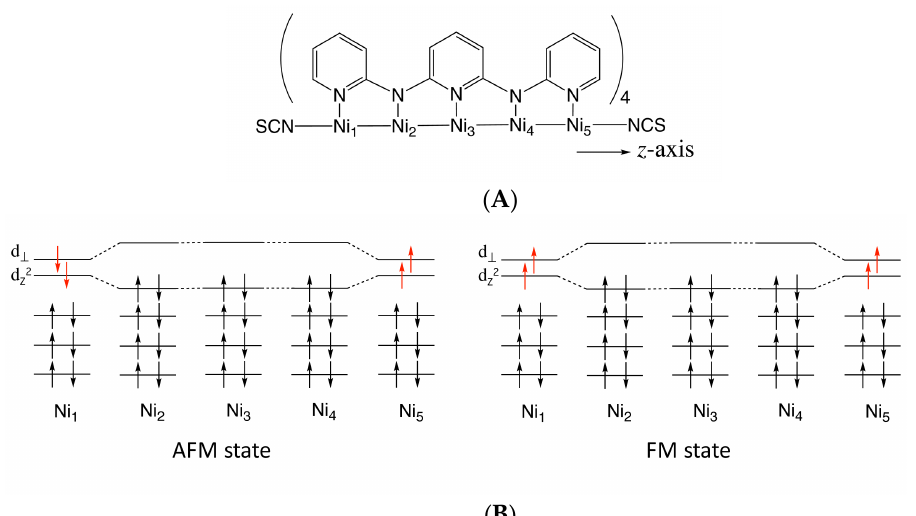
Figure 1. ( A ) Illustration of the molecular structure of [Ni 5 (tpda) 4 (NCS) 2 ] (tpda: tripyridyldiamine) ( 1 ). The z -axis was fixed along the chain axis. ( B ) Spin structure of the anti-ferromagnetic (AFM) and ferromagnetic (FM) states of complex 1 . The d z2 orbital becomes one of the magnetic orbitals. Because of the helical structures of the oligo- α -pyridylamino ligands, another magnetic orbital (d ⊥ ) is expressed by hybridization of d x2 - y2 and d xy orbitals.